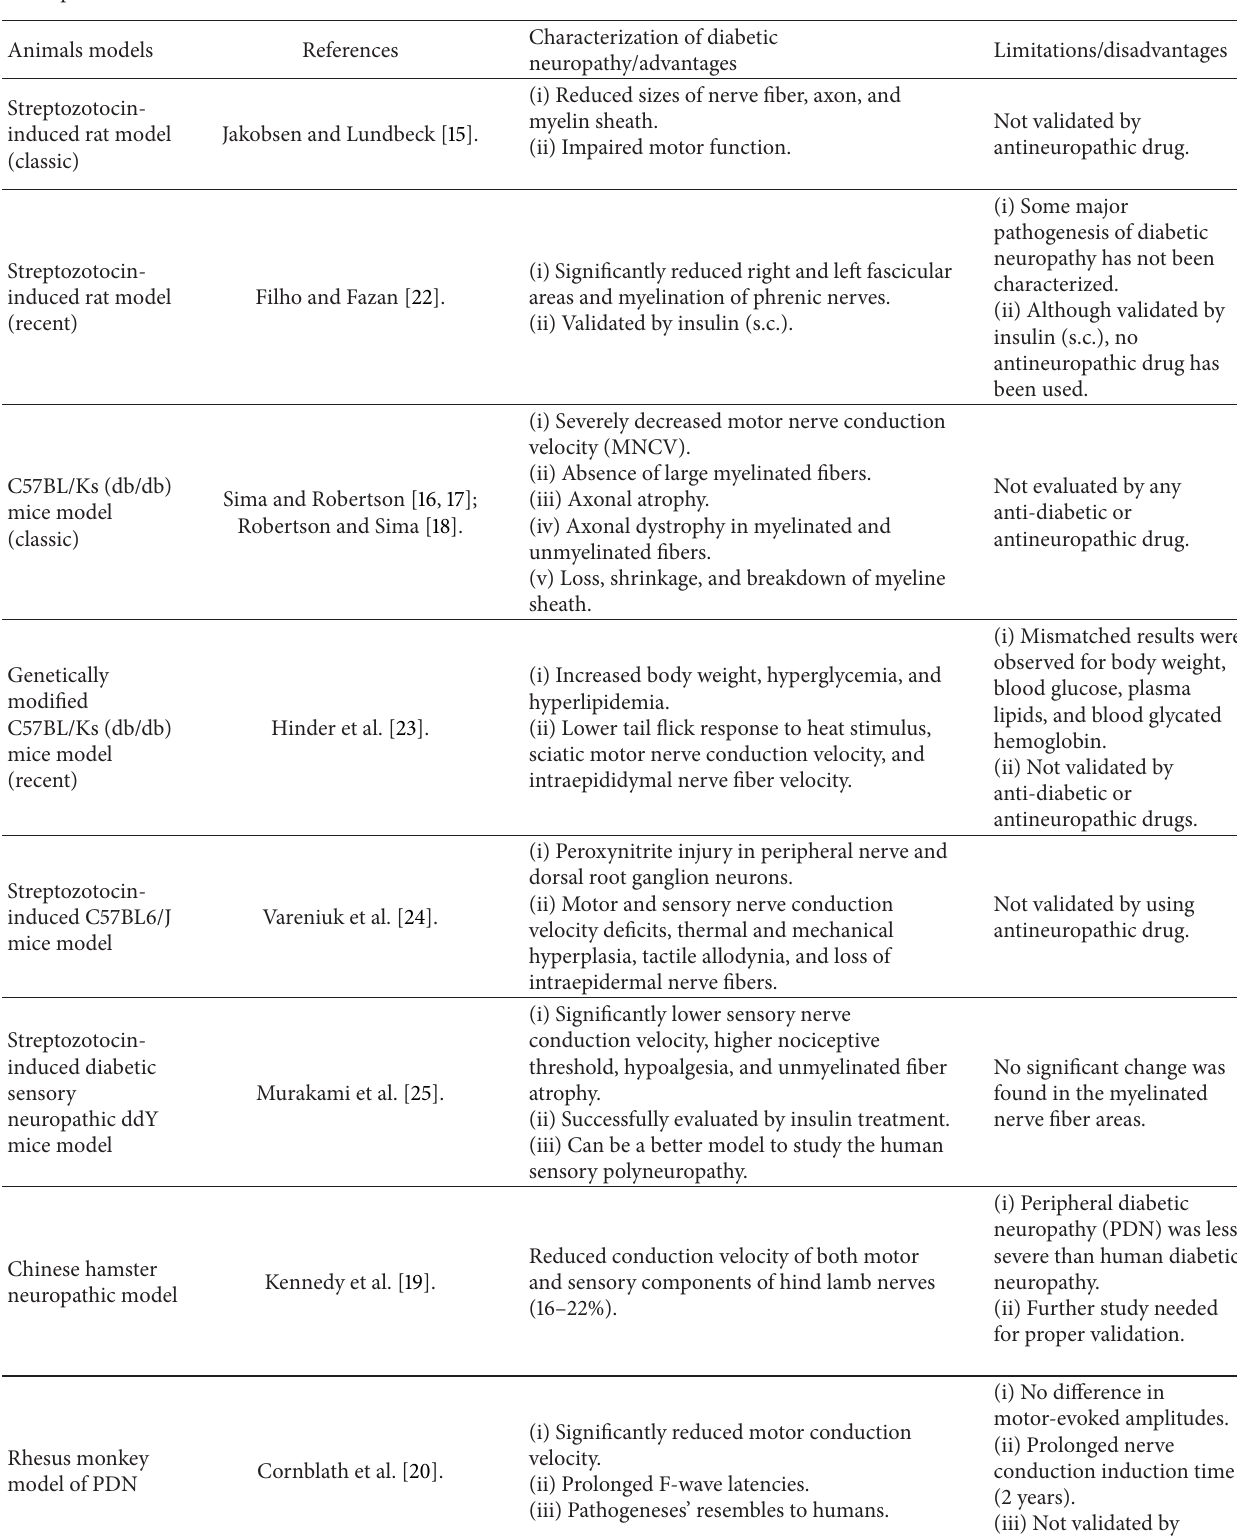
Table 1: Characterization criteria (advantages) and limitations (disadvantages) of some selective animal models of diabetic neuropathy developed since